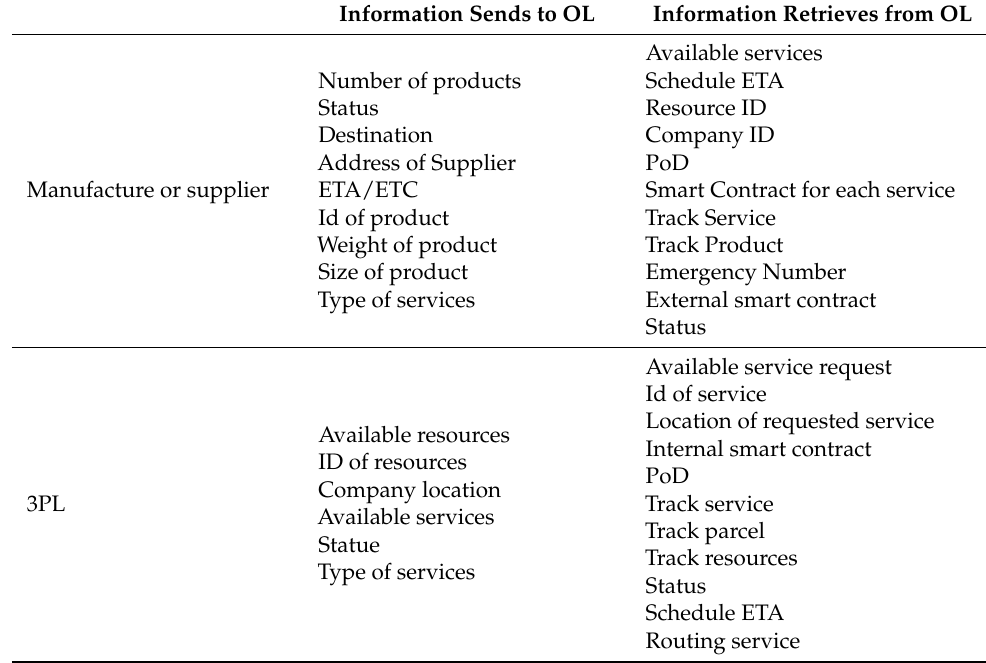
Table 2. Information between supplier (service user) and 3PL